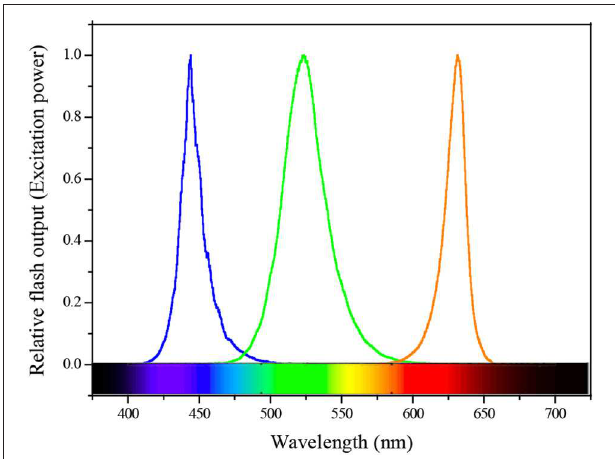
FIGURE 2 | Spectral quality of the actinic flash and excitation power used for FRRF3